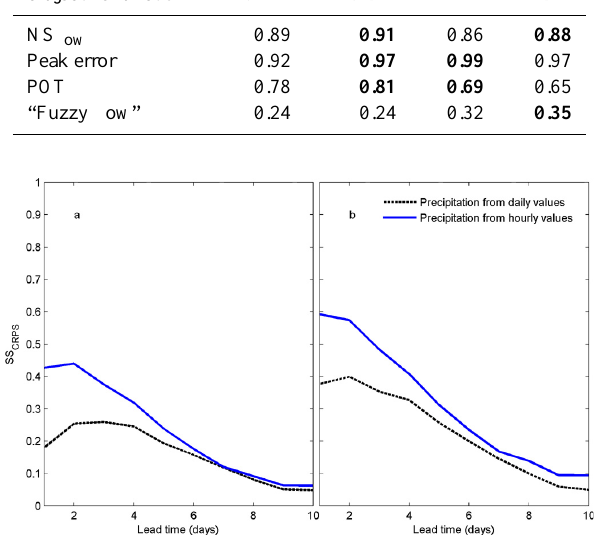
Fig. 3. SS CRPS for the entire period (1 October 2006–31 December 2009) for (a) 1-km gridded precipitation and (b) for the precipita- tion accumulated over the entire catchment. The black (dotted) line denotes DP and the blue (full) line